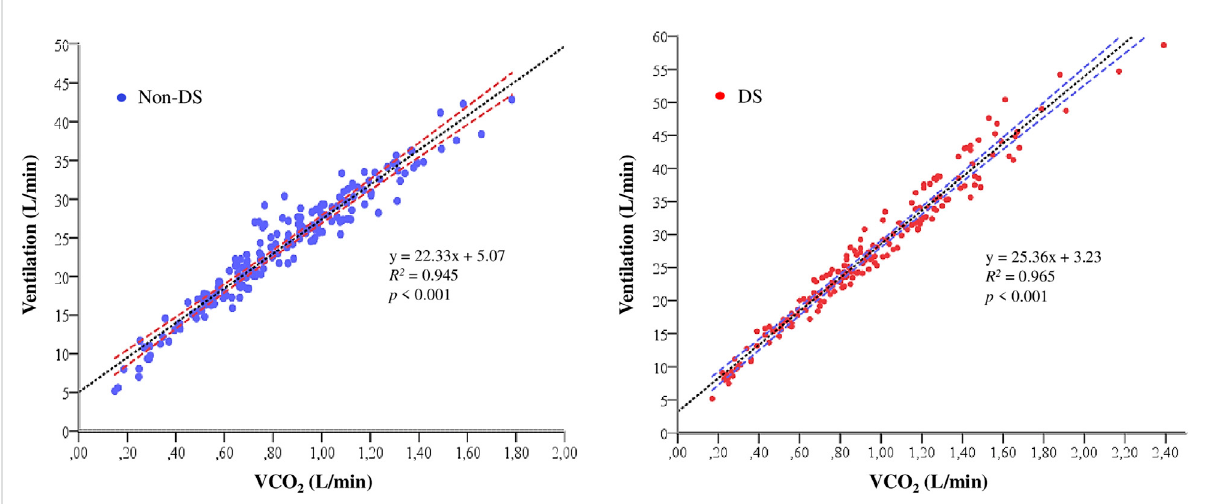
Relationship between ventilation (VE; L/min) and carbon dioxide production (VCO 2 ; L/min) during the submaximal phases of the treadmill test. Abbreviations: DS (Down